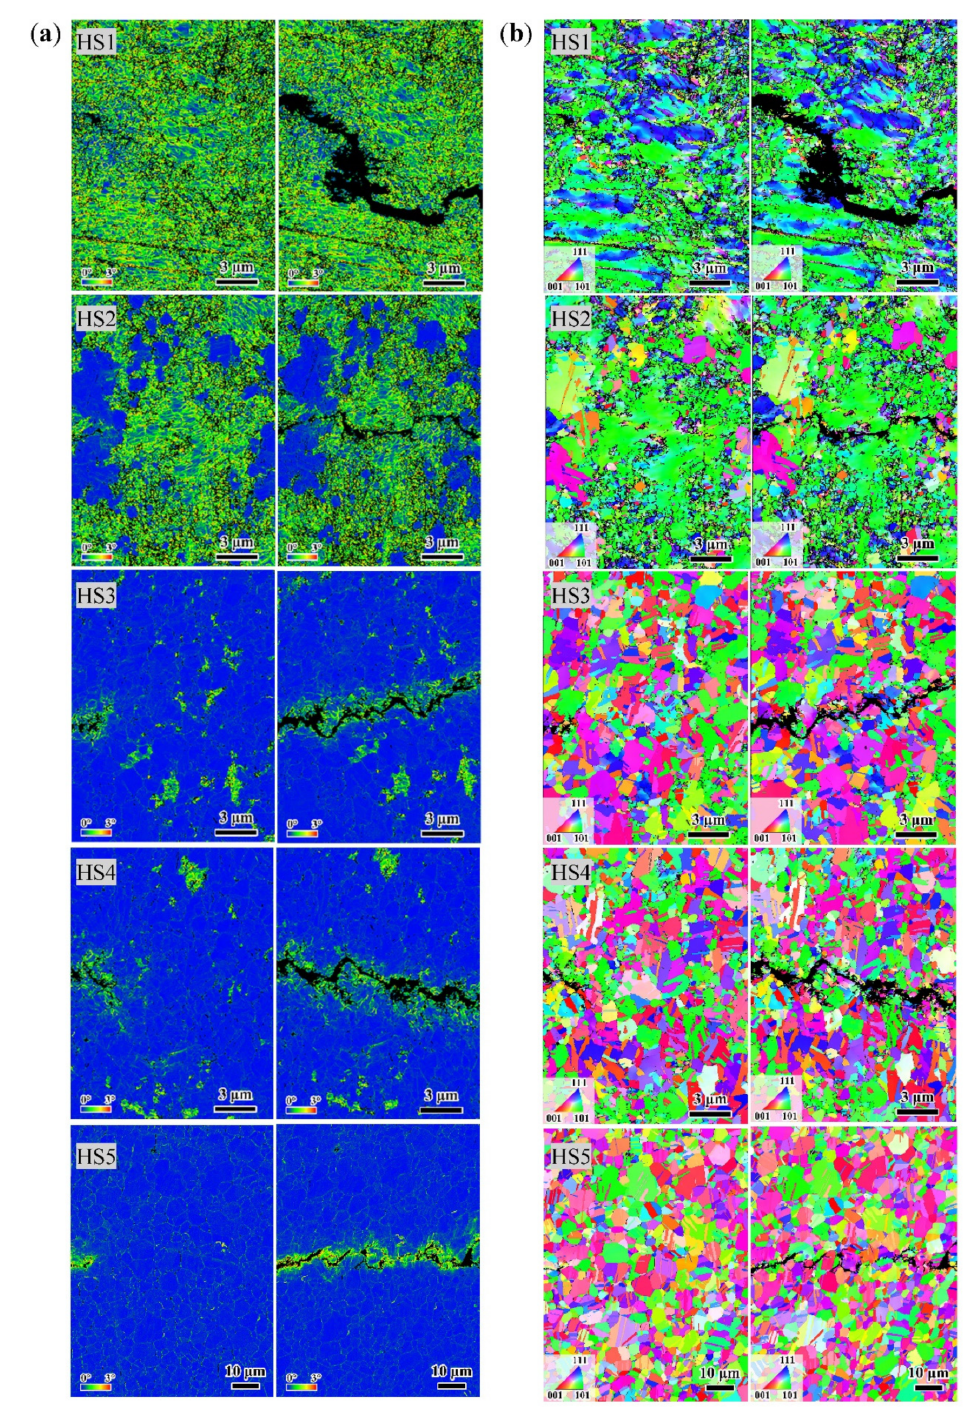
Figure 7. The EBSD maps of the in situ fatigue crack propagation. For each specimen, the left map was acquired at the front of the crack tip and the right map was acquired at the same site, but after crack growth. ( a ) KAM maps. ( b ) Orientation